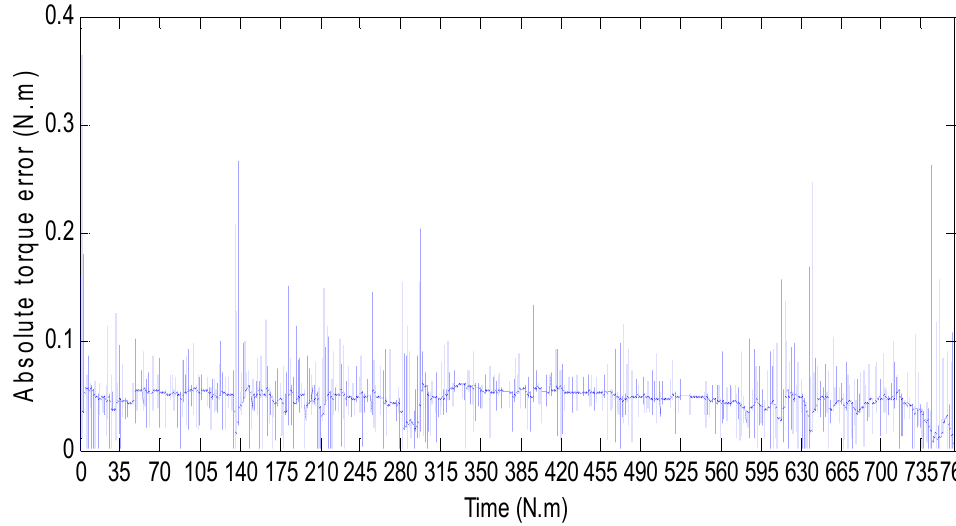
Figure 32. BEV torque response and its reference for HWEFT driving cycle.